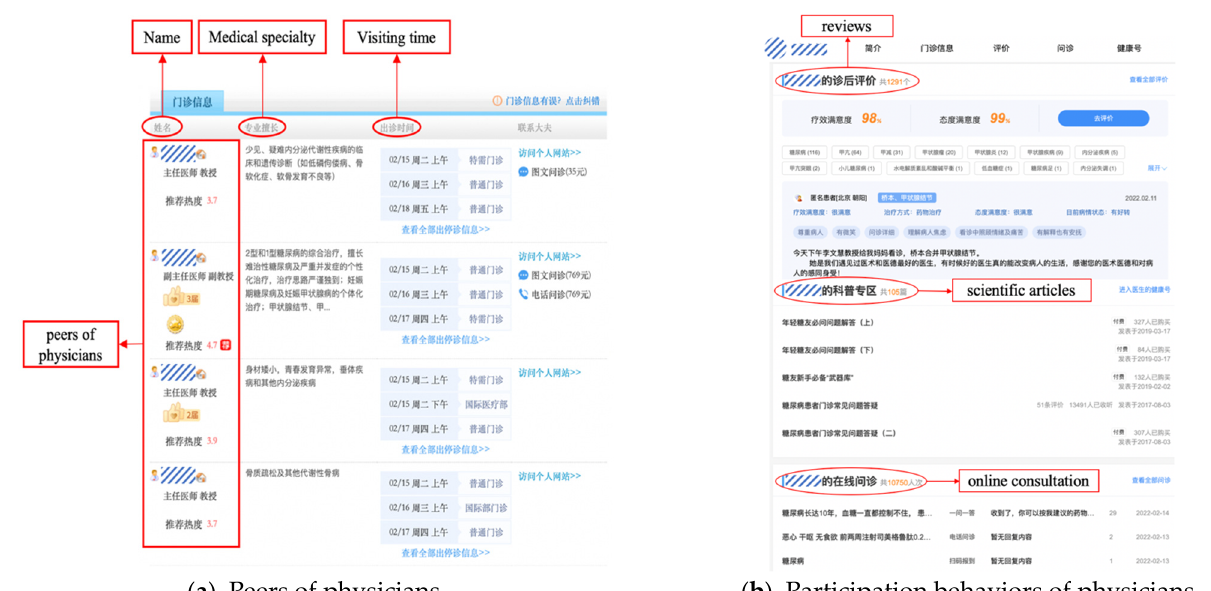
Figure 1. The partial layout and functions of haodf.com, accessed on 1 January